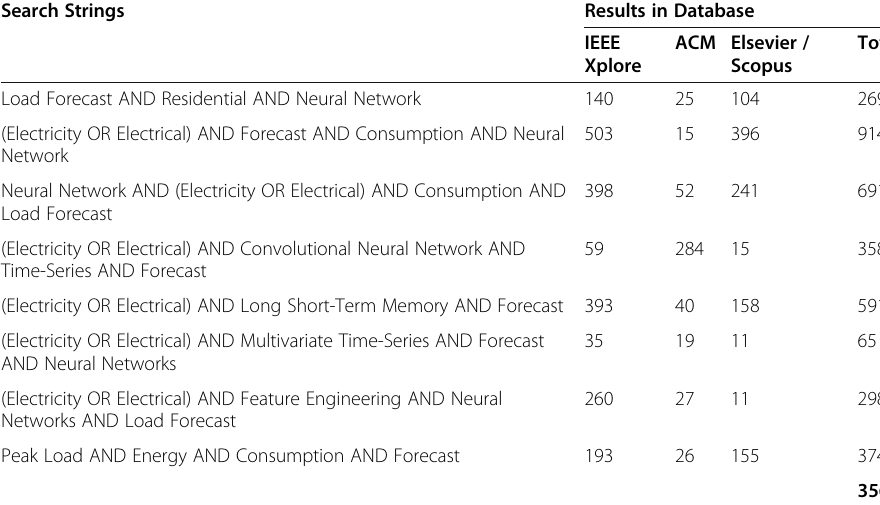
Table 1 Results of keyword search in databases Search Strings